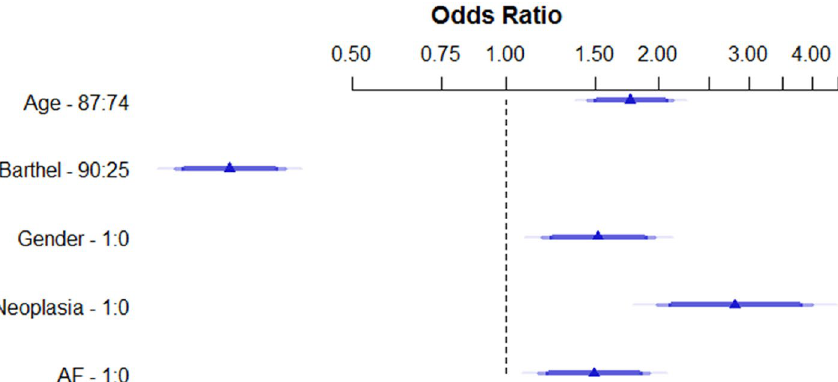
Figure 1. Multivariate analysis. Logistic regression analysis with the 5 variables identified as significantly associated to one-year mortality applied to the global sample.